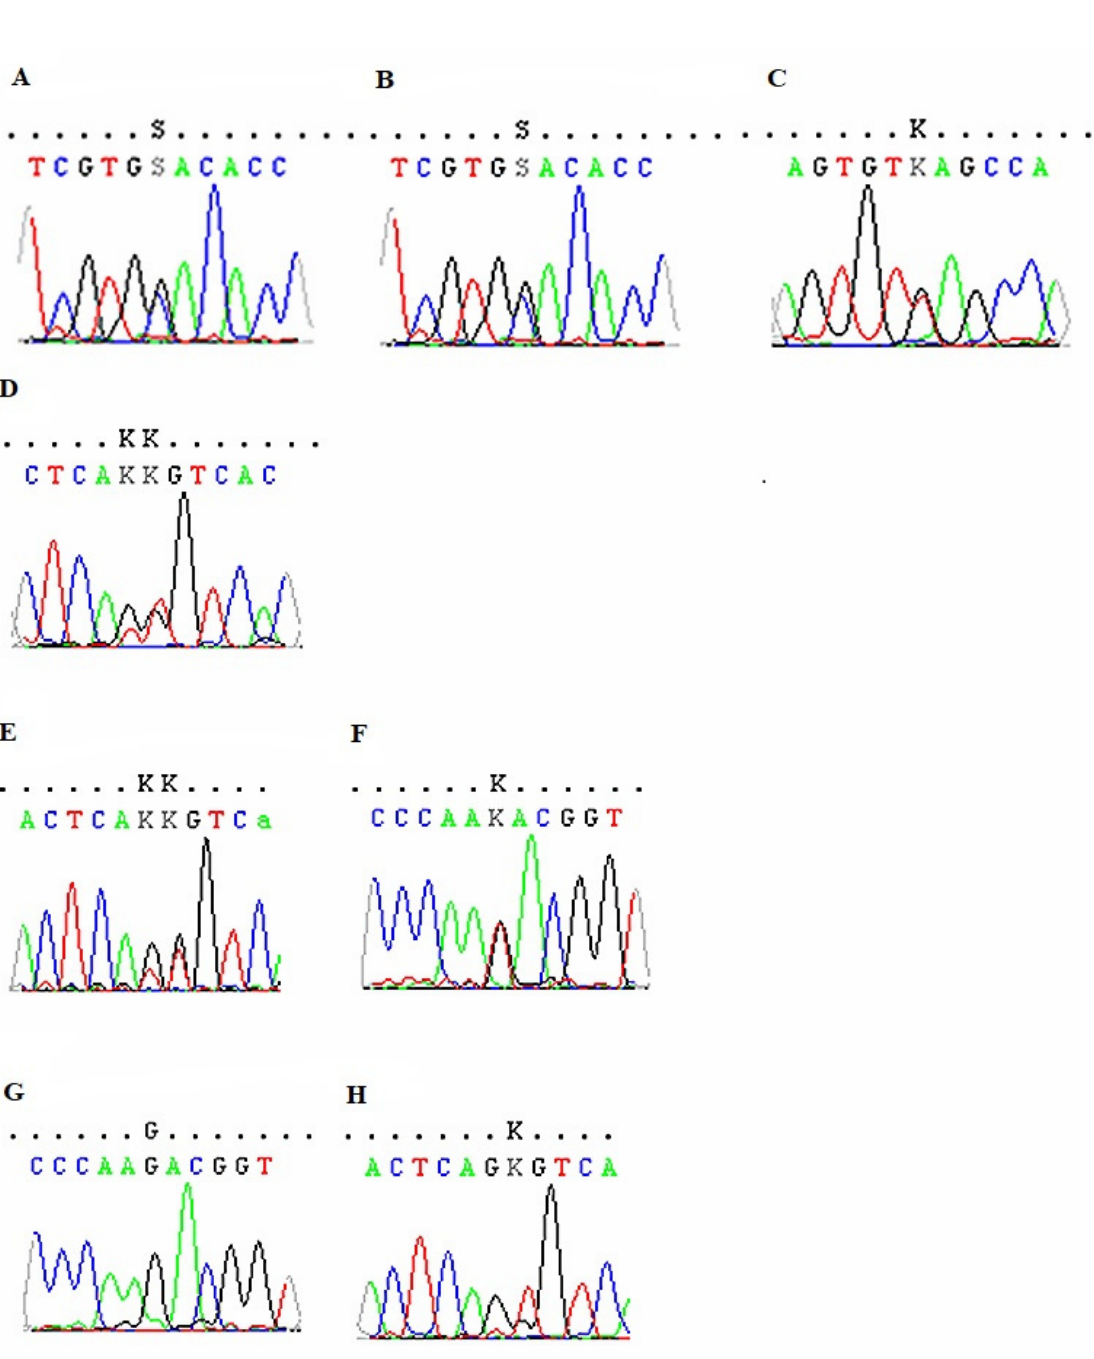
Figure 1. FLG sequencing electropherograms of the four (1–4) studied cases—variants in case 1: ( A )—[p.(Gly843Ala)]; ( B ) —[p.(Val2891=)]; ( C )—[p.(Tyr3105Asp)]; variant in case 2: ( D )—p.(Val3179Gly)]; variants in case 3: ( E )—[p.(Tyr3105Asp)]; ( F )—[p.(Val3179Gly)]; var-iants in case 4: ( G )—[p.(Tyr3105Asp)]; ( H )—[p.(Val3179Gly)].